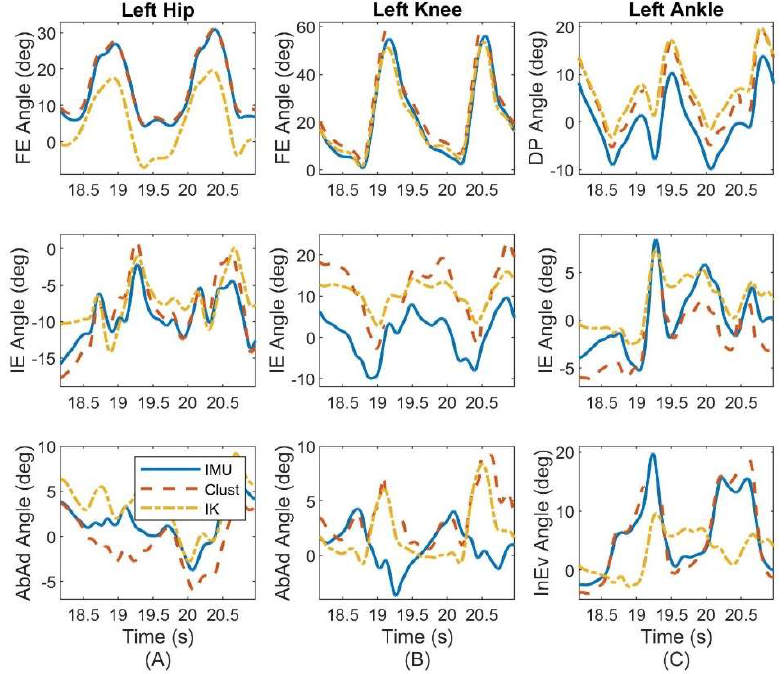
Figure A4. Backward Walking. Example joint angle estimates over two stride cycles for backward treadmill walking. Plots show the three anatomical angles for ( A ) left hip, ( B ) left knee, and ( C ) left ankle. Estimates are also compared between ErKF (IMU), cluster (Clust), and inverse kinematics (IK) methods.